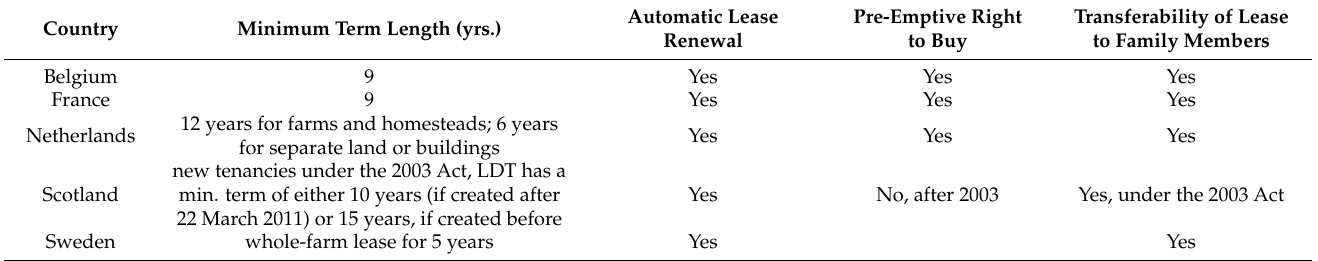
Table 2. Policies to support long-term land leasing in selected